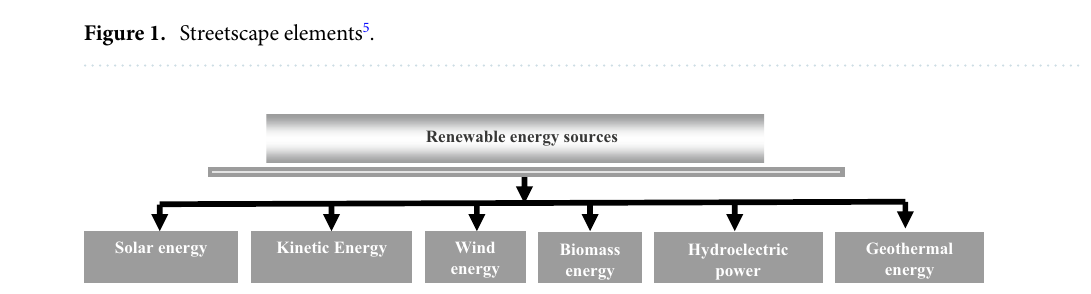
Figure 1. Streetscape elements 5 .